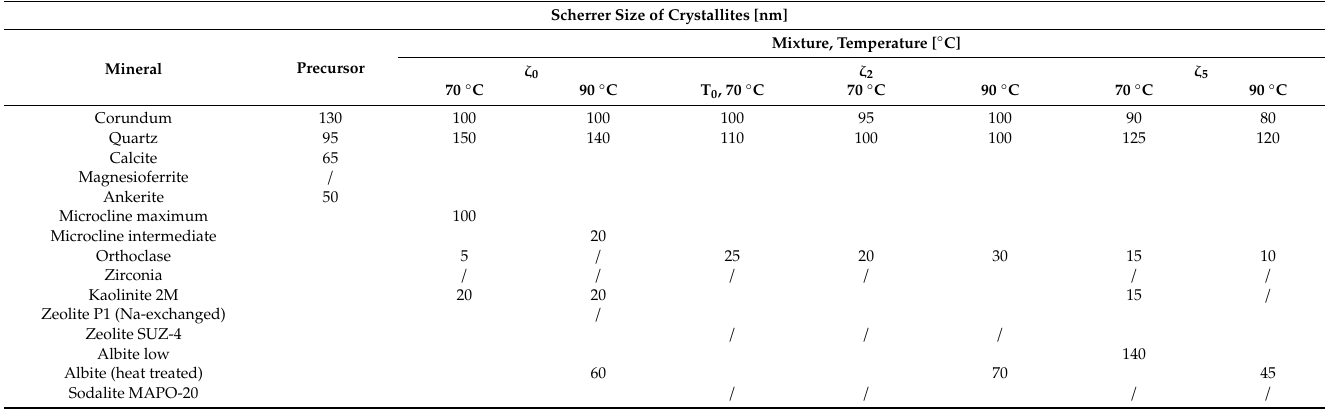
Table 7. Scherrer crystallite sizes from XRD measurements performed on the precursor and one-month old AAM synthesized using 50 g of mixtures ζ 0 , ζ 2 , and ζ 5 , cured on room temperature followed by curing at 70, at 70 and 90 ◦ C. Empty cells: Mineral is not present. “ / ”: Mineral is present, but crystallites are too big for valid determination of the diameter with Scherrer equation with X’Pert Highscore software (valid is up to 150 nm